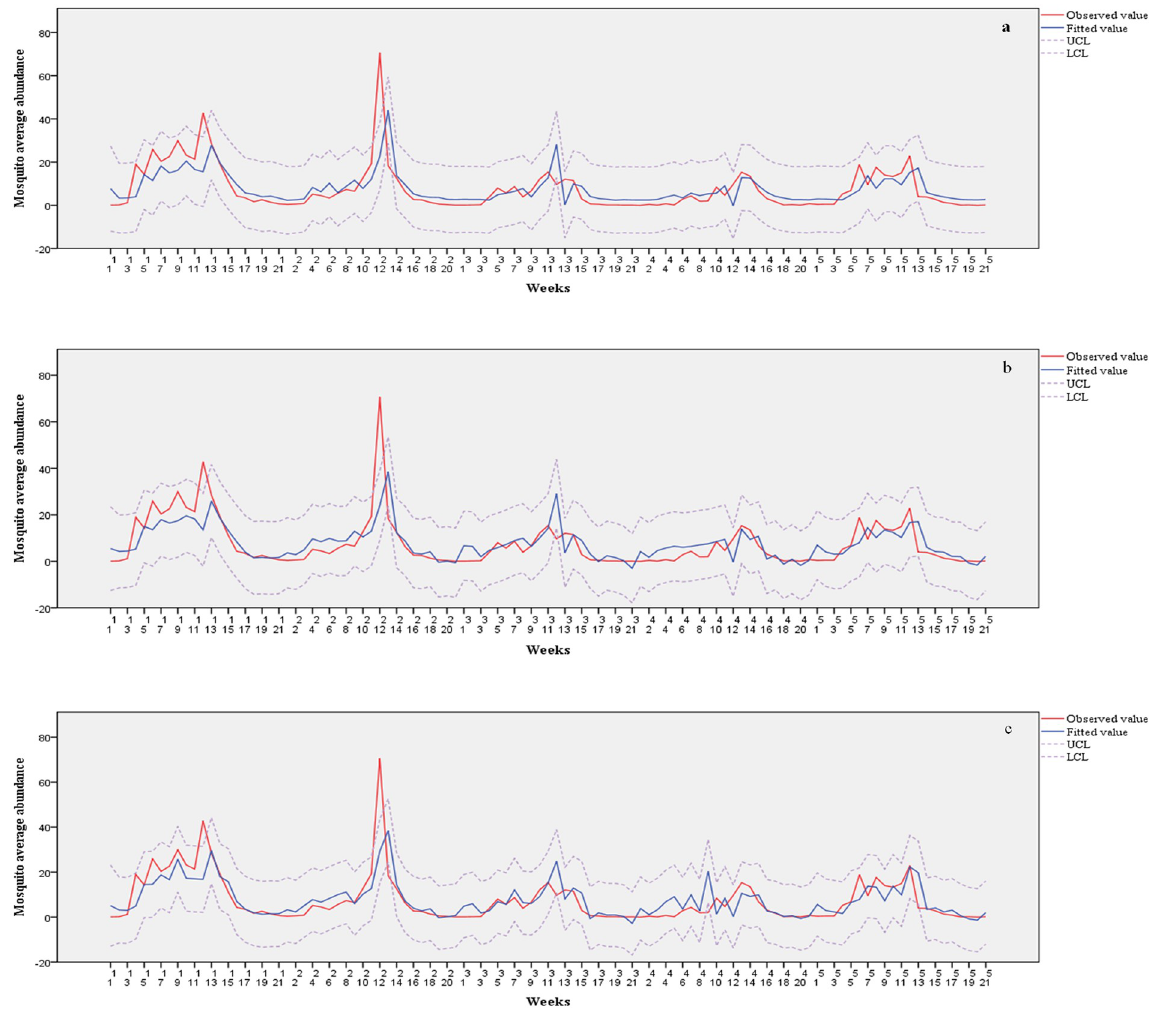
Fig 3. Fitted values of model and observed values for Anopheles sinensis average abundance in Goyang, Korea, 2008–2012. a: Model 0, b: Model 1 c: Model